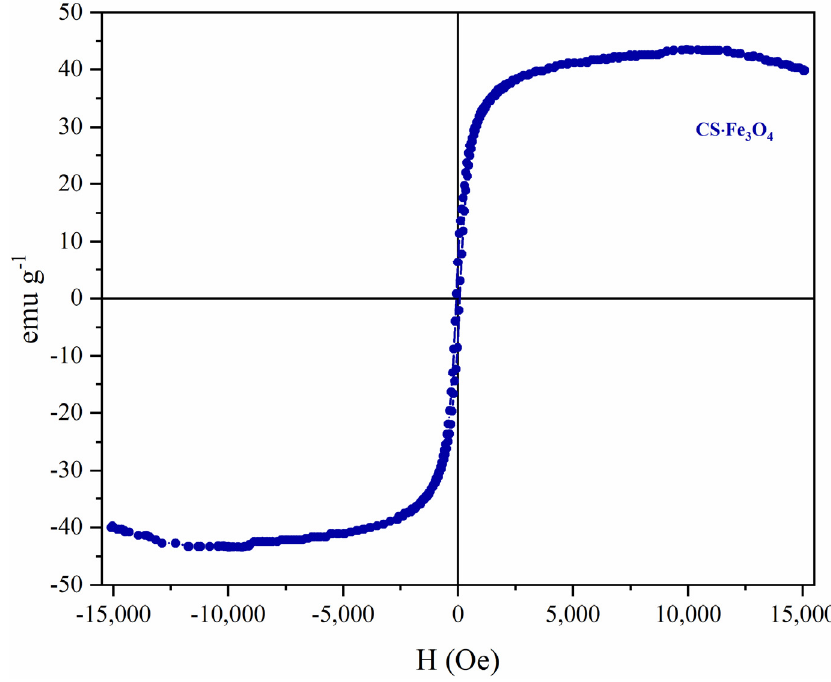
Figure 5. Hysteresis curve of CS · Fe 3 O 4 .